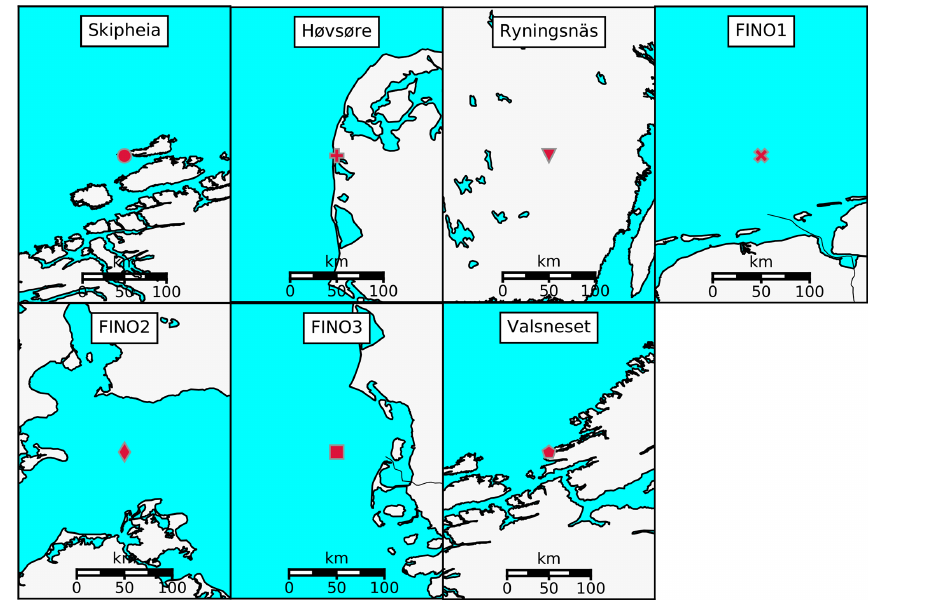
times of year which had a recording time equivalent to well over 1 year of